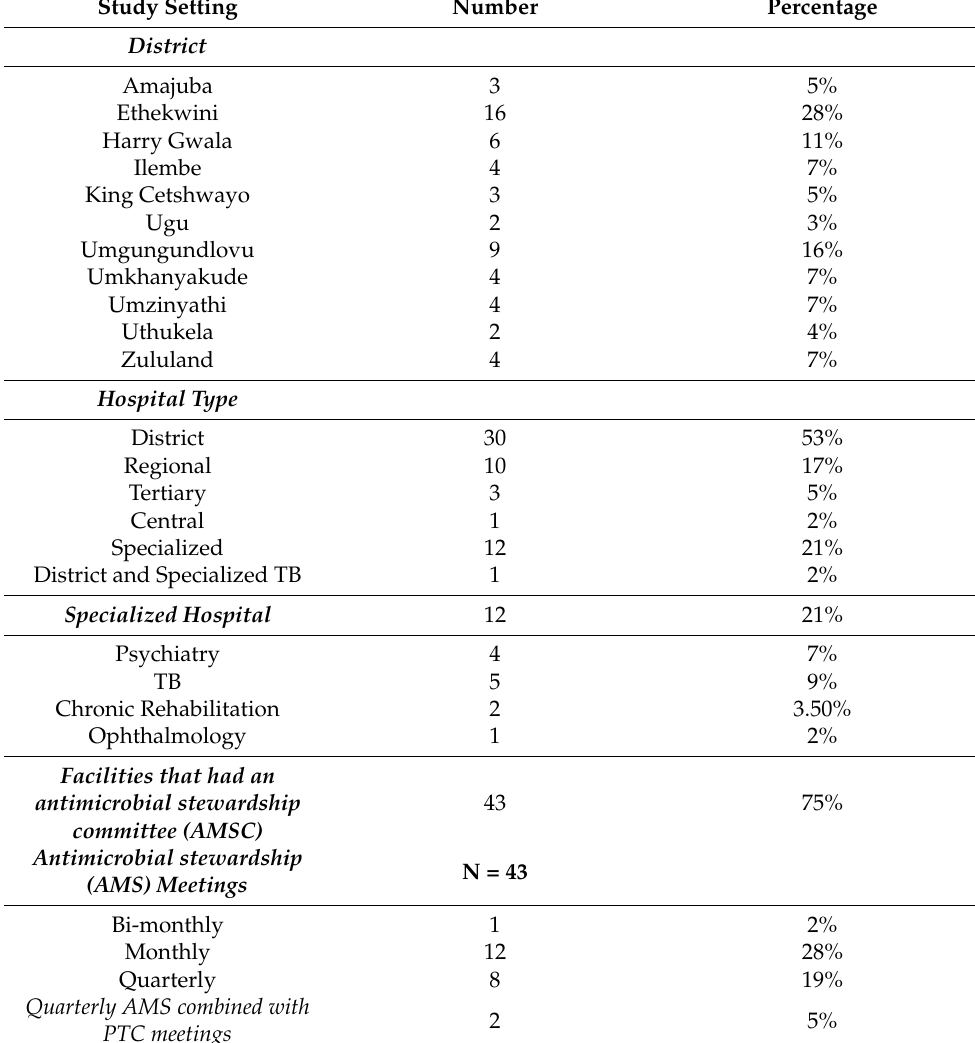
Table 1. Responses stratified by district, hospital type, and existing antimicrobial stewardship committee